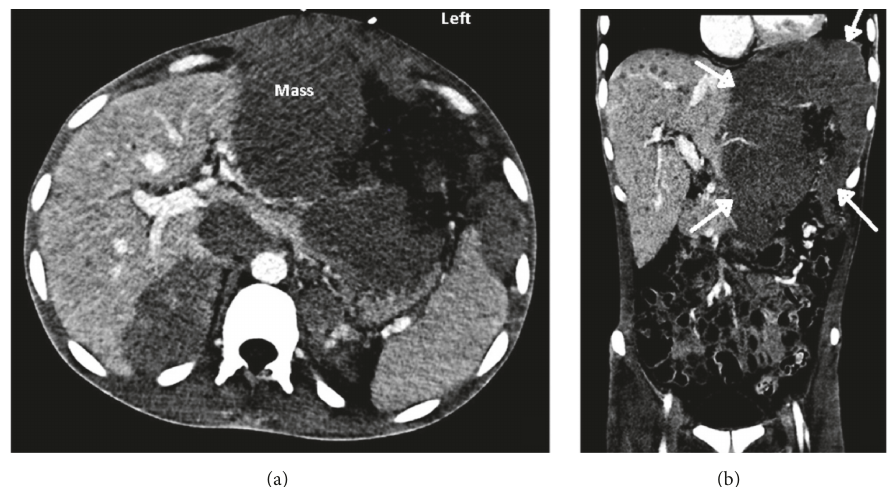
Figure 1: (a) Computed tomography with contrast of abdomen showing 16.3 cm × 14.1 cm × 20 cm hepatic mass (axial view). (b) Computed tomography with contrast of abdomen showing mass (arrows) involving the left hepatic lobe (coronal